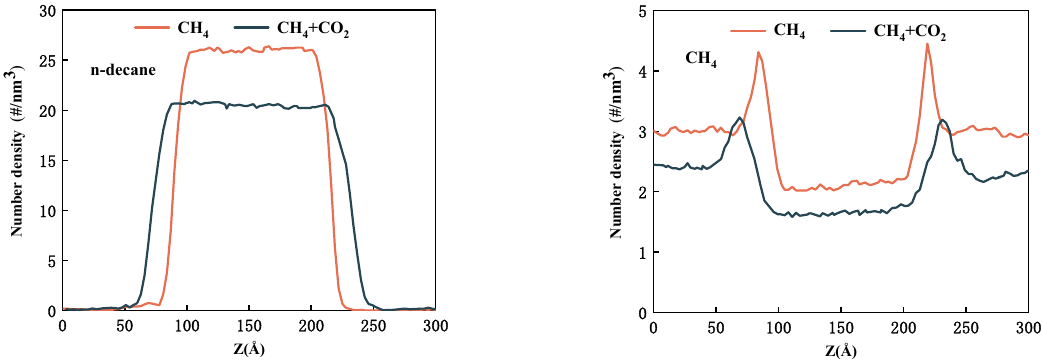
Figure 5. Number density distribution of CH 4 /n-decane before and after CO 2 injection at 313.3 K, 11.14 MPa. (The # symbol in the unit represents the number of molecules).